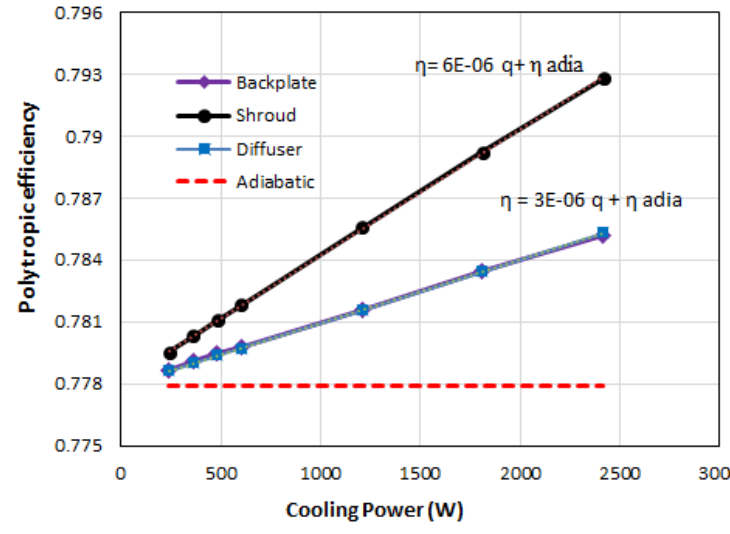
Figure 10 . Effect of the cooling temperature on the polytropic efficiency. Figure 10. Effect of the cooling temperature on the polytropic